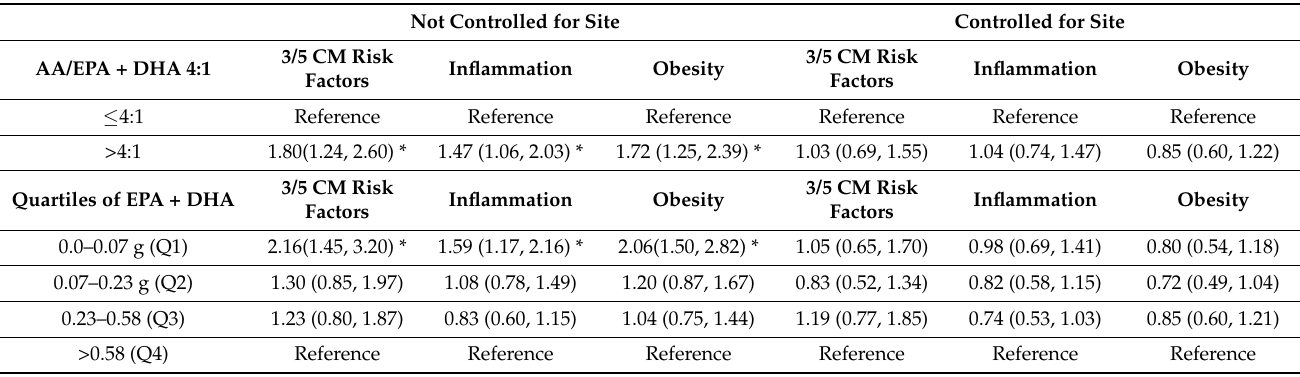
Table 4. Adjusted odds ratios for cardiometabolic risk based on the AA/EPA + DHA ratio of 4:1 intake in four countries across the epidemiological transition.